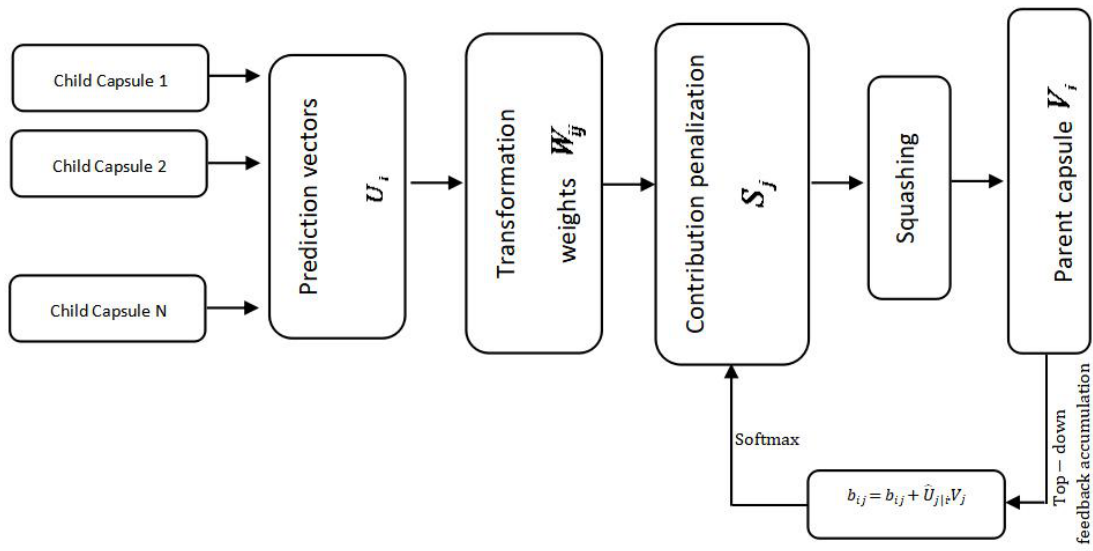
Figure 1. Abstract illustration of the routing by agreement